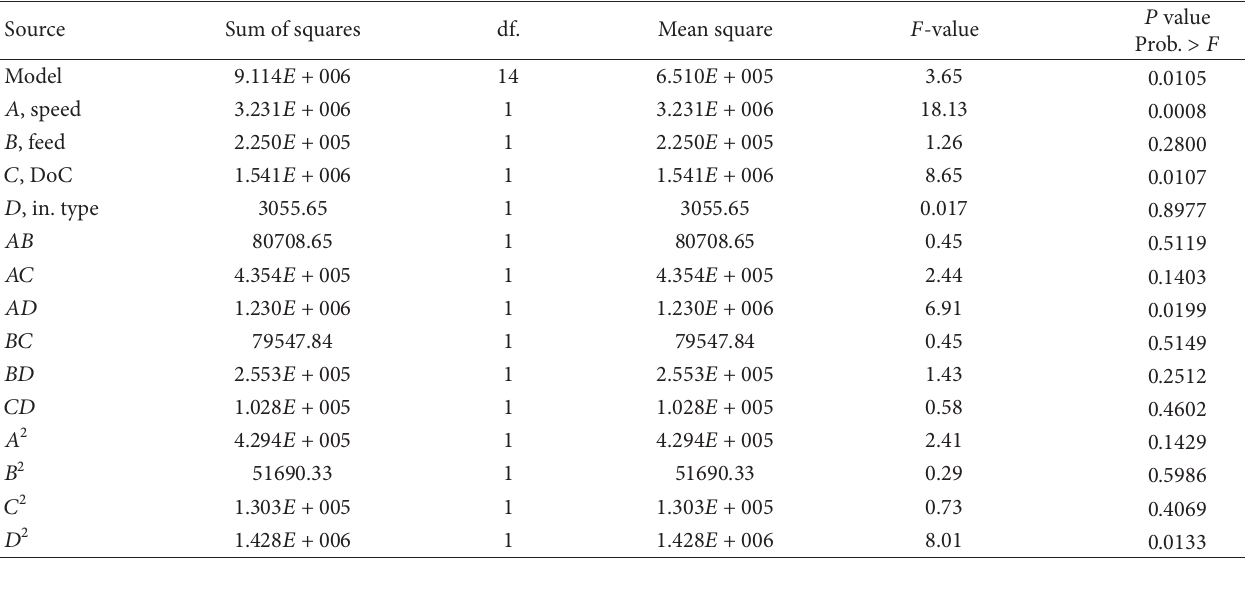
Table 5: ANOVA for Response-2 material removal rate.